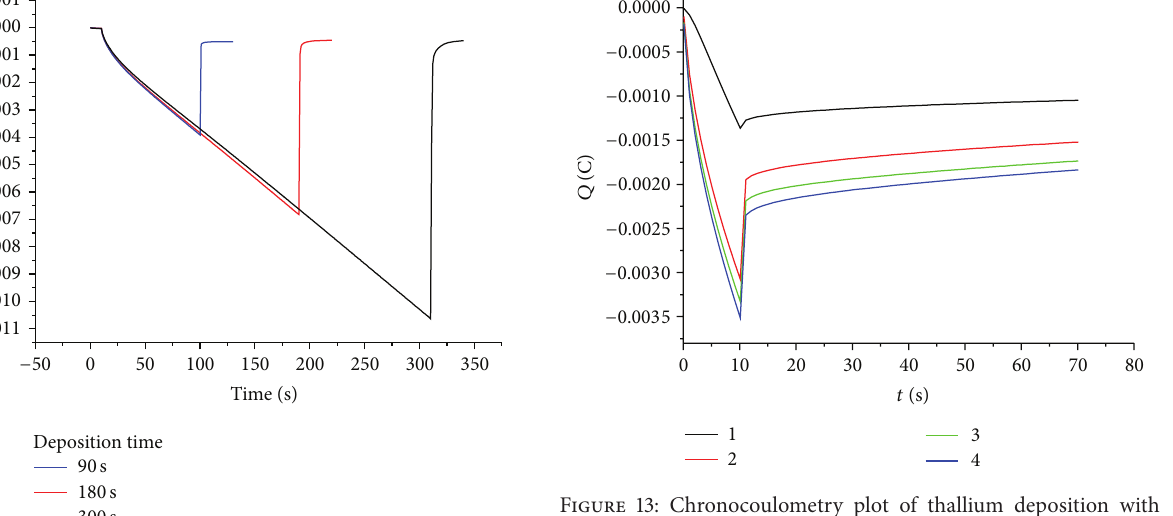
Figure 13: Chronocoulometry plot of thallium deposition with varying time and removal on glassy carbon electrode in the presence of 1mM TlSO 4 in 0.5 M Na 2 SO 4 solution in the presence of